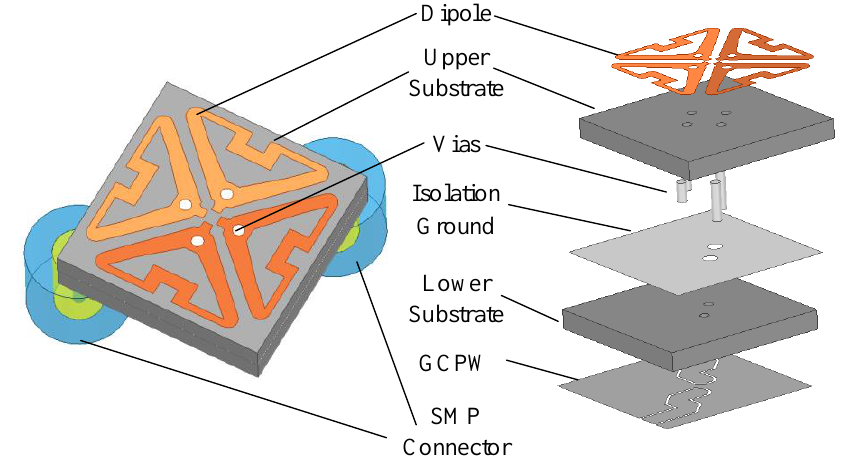
Figure 1. Dipole Antenna model.